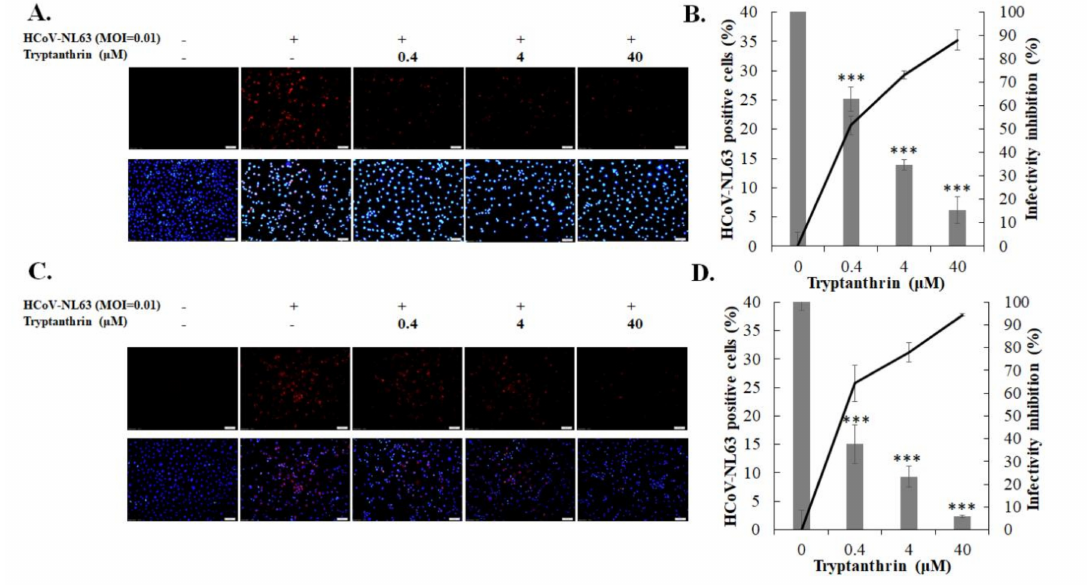
Figure 6. Time-of-addition and removal assay for analyzing antiviral action of tryptanthrin against HCoV-NL63. The cell monolayer was infected with HCoV-NL63 and treated with tryptanthrin simultaneously ( A , early stage), or 1 hpi ( C , late stage). After a 2 h of incubation, the virus / tryptanthrin mixture was removed; the cell monolayer was washed with PBS and cultured for an additional 36 h with incubation at 37 ◦ C , and then subjected to immunofluorescence staining using anti-HCoV-NL63 antibodies plus secondary antibody Alexa Fluor anti-mouse IgG ( A , C , top) and DAPI ( A , C , bottom). Infectivity was determined according to the percentage of HCoV-NL63-positive cells ( B , D ). + , add; − , not add; ***, p value < 0.001 compared with untreated infected group. Scale bar, 100 µ